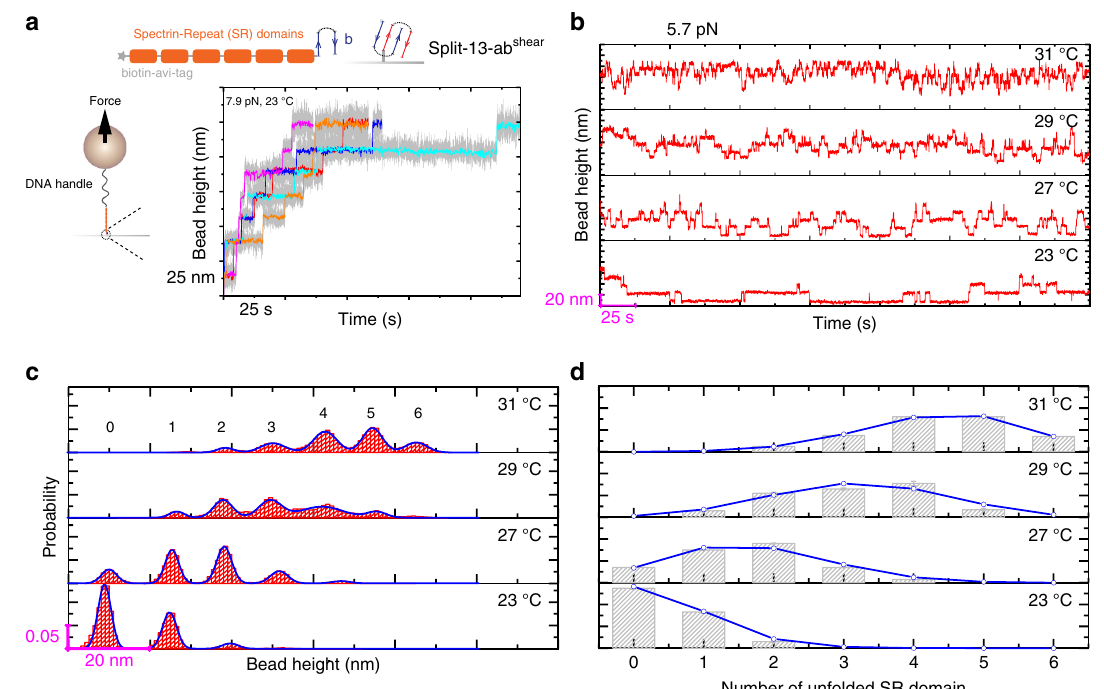
Fig. 6 Temperature-dependent α -actinin SR4 unfolding/refolding dynamics. a Top panel: experimental design of utilizing the split-13-ab shear to anchor a protein construct (bio-6SR-b) that contains six repeats of the fourth spectrin-repeat domain to glass surface. The six SR domains are spanned between an avi-biotin tag at N-terminus and the #13-b helix-hairpin at the C-terminus. The bio-6SR-b construct is speci fi cally tethered to the #13-a helix-hairpin coated bottom surface via formation of split-13-ab shear complex, and the N-terminus is tethered to the DNA-coated magnetic bead through biotin – streptavidin interaction (Supplementary Note 2). Bottom panel: fi ve representative time traces of the bead height obtained from fi ve independent tethers under a constant force of ~7.9 pN at 23 °C. The six stepwise extension increase events with a step size of ~25 nm in each time trace indicate SR unfolding. Colored lines are 20-points FFT smooth of the raw data (gray). b Representative time traces of the bead height (20-points FFT smoothed) under a constant force of ~5.7 pN at multiple temperatures (23, 27, 29, and 31 °C). The stepwise extension increases and decreases with step sizes of ~18 nm indicate unfolding/ refolding of the SR domains. c The resulting probability distributions of the bead height. The numbers of unfolded spectrin-repeat domains at corresponding bead height are indicated. Blue line is the multiple peak Gaussian fi tting of the bead height probability distributions. d The bar graph shows the probability of having n unfolded SR domains in the six SR domains obtained from the bead height distribution in c . The error bar indicates the standard error, which are obtained through multiple peak Gaussian fi tting of the bead height probability distributions. Blue curve indicates the fi tting of the bar graph to the binomial distribution. Source data are provided in Source Data fi